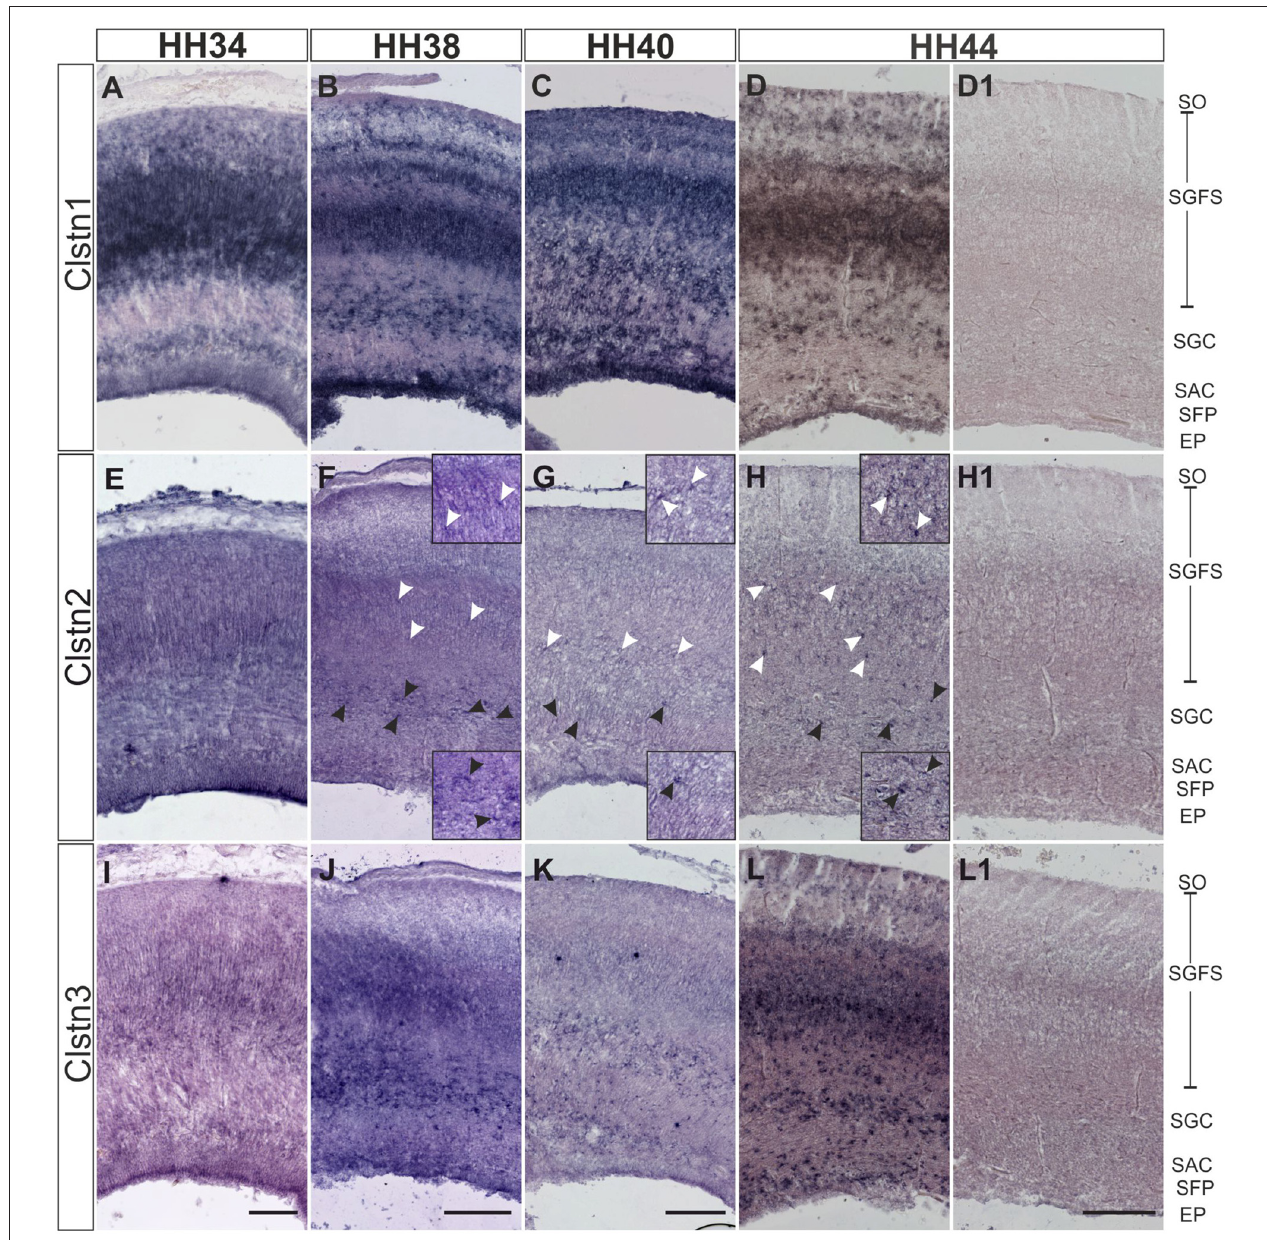
FIGURE 5 | Calsyntenins are expressed in the developing tectum. Clstn1 is expressed in newly forming layers throughout development. By HH34 (A) Clstn1 mRNA was found mainly in the upper layers of the developing tectum. As layers form by splitting by HH38 (B) and HH40 (C) , the Clstn1 expression pattern changes accordingly. By HH44 (D) , Clstn1 was found in the SGFS and in the SGC, in some cells of the SAC, as well as in the EP. In contrast, Clstn2 expression is not dynamic. Expression is ubiquitous at HH34 (E) but then gradually decreases. It was still readily detectable in most layers by HH38 (F) but by HH40 (G) and especially by HH44 (H) expression of Clstn2 is only retained in very few cells of the SGFS and the SGC. Insets in (F–H) are higher magnification views of Clstn2-positive cells in the SGFS (white arrowheads) and in the SGC (black arrowheads). Clstn3 expression resembled Clstn1 at HH34 (I) . Expression does not change much by HH38 (J) . By HH40 (K) expression of Clstn3 has decreased in upper layers. By HH44 (L) , expression of Clstn3 is again similar to Clstn1. (D1,H1,L1) show sections corresponding to (D,H,L) processed with the respective sense probes. SO, stratum opticum; SGFS, stratum griseum and fibrosum superficiale; SGC, stratum griseum centrale; SAC, stratum album centrale; SFP, stratum fibrosum periventriculare; EP, ependymal layer. Bar: 200 µ m.